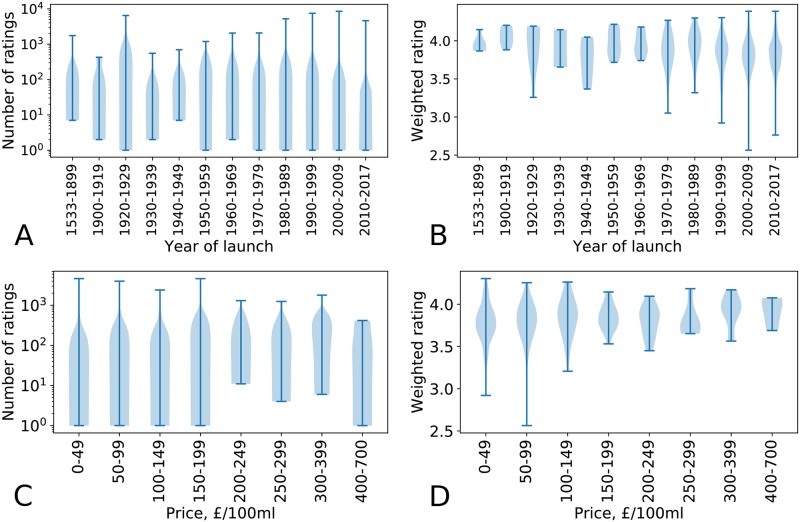
On the left, the number of launches in each time period.Note the first two point cover more than a decade but all the others are decades. Note the roughly exponential rise from the 1950’s. On the right, the number of perfumes launched in various price brackets. The density of perfumes per bin is shown and these are plotted at the mid-point of the bin. Again the distribution falls off roughly exponentially.